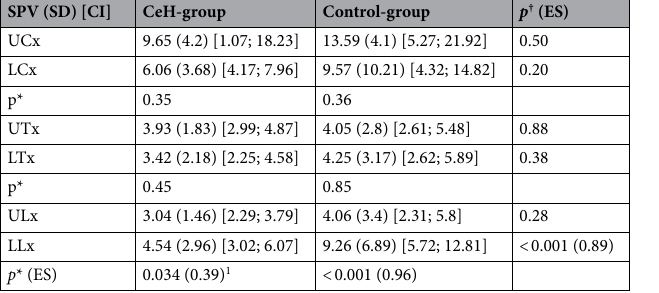
Table 3. Comparison of SPV in the CeH-group (n = 18) and control-group (n = 18). SD = Standard deviation; CI = 95% Confidence interval; † = unpaired t-test; * = paired t test; ES = Effect size; 1 = 1-sided t test p = 0.017; Bold numbers = p <